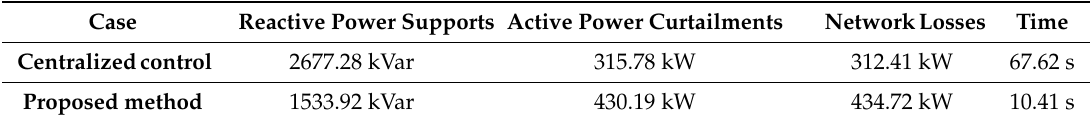
Table 3. Comparison of the Two